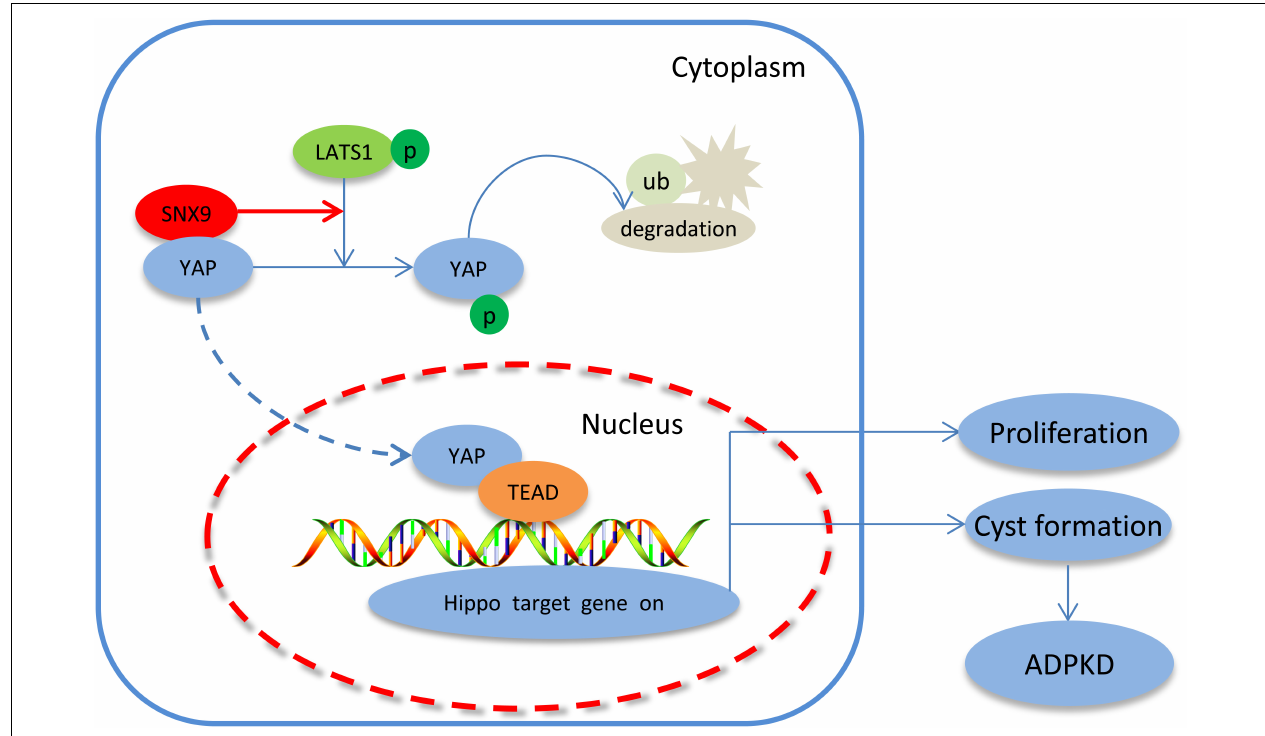
FIGURE 7 | Proposed signaling pathways involved in the SNX9-induced inhibition of ADPKD development. SNX9 interacted directly with YAP, which increased the LATS1-mediated phosphorylation of YAP, leading to the cytoplasmic retention of YAP and the decreased transcriptional activity of the YAP/TEAD4 complex, and, consequently, inhibited the expression of Hippo target genes and ADPKD